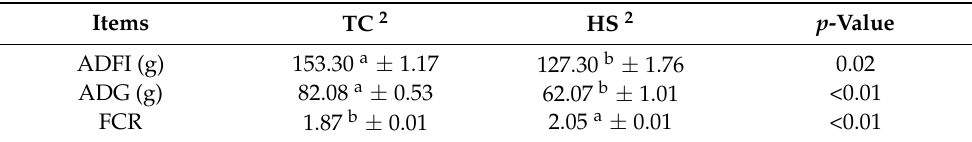
Table 2. Effects of heat stress on the growth performance of broilers 1